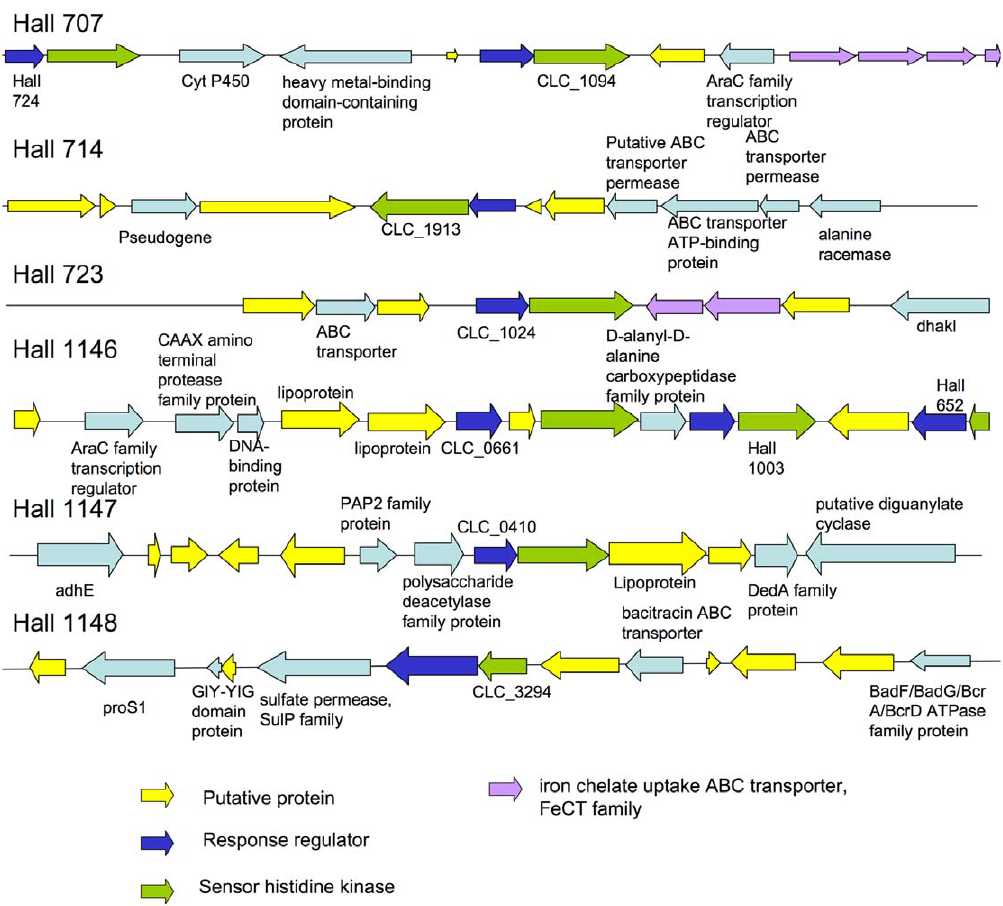
Figure 9. Genetic environment of the TCS genes involved in the regulation of toxin synthesis in strain Hall.